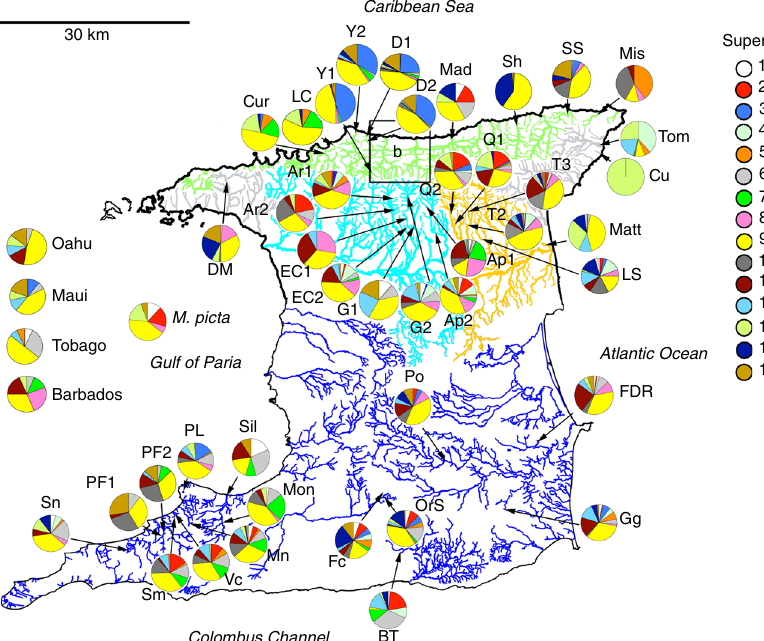
Fig. 3 The geographic distribution of MHC supertypes (ST) in guppy populations across Trinidad and other oceanic islands. Rivers in the mountainous Northern range comprise three major regions: The North Slope (green), Caroni Drainage (light blue) and Oropouche drainage (orange). Other independent drainages in the Northern range are shown in grey. Rivers in the relatively fl at regions towards the south are shown in dark blue. See Supplementary Fig. 6 for abbreviated population names and populations in region b. ST-9 is observed across 95% of populations and maintained in similar frequencies, despite wide variation in the frequencies and presence of the 55 ST-9 alleles. Importantly, Micropoecilia picta shares STs with the guppy, despite complete allelic divergence. ST-9 is similarly high in frequency in M. picta , as well as on Barbados and Hawaii, where (except for Tobago) guppies where introduced by humans. Scale – 30